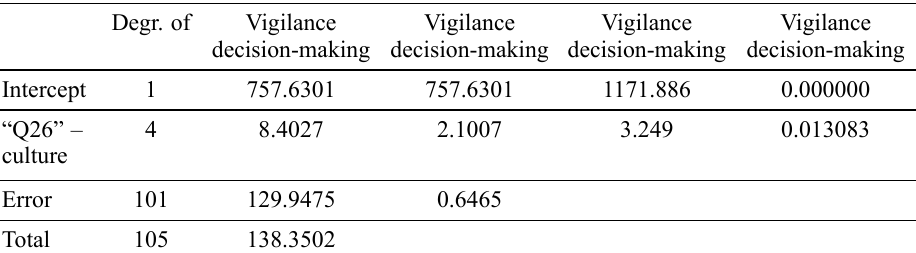
Table 9. Variance analysis